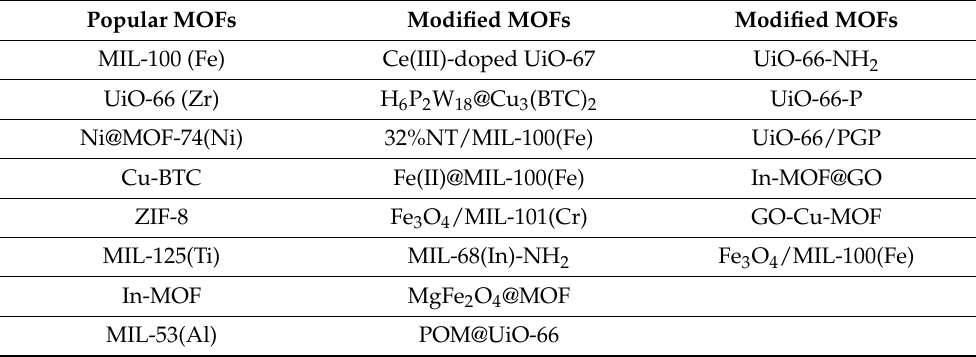
Table 3. Building blocks of different popular MOFs and modified MOFs